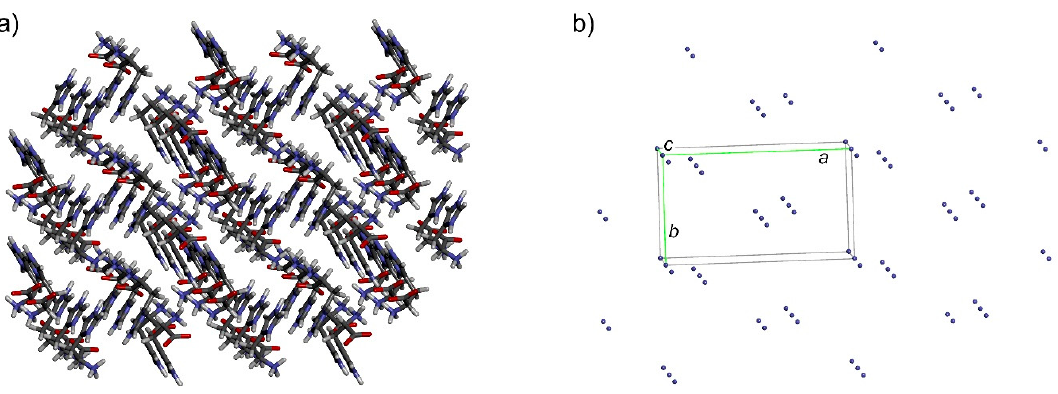
Figure 11. A derivation of the cell lattice parameters from the molecular framework; ( a ) molecular packing in stick presentation, ( b ) projection of molecular packing using only one atom of each molecule.